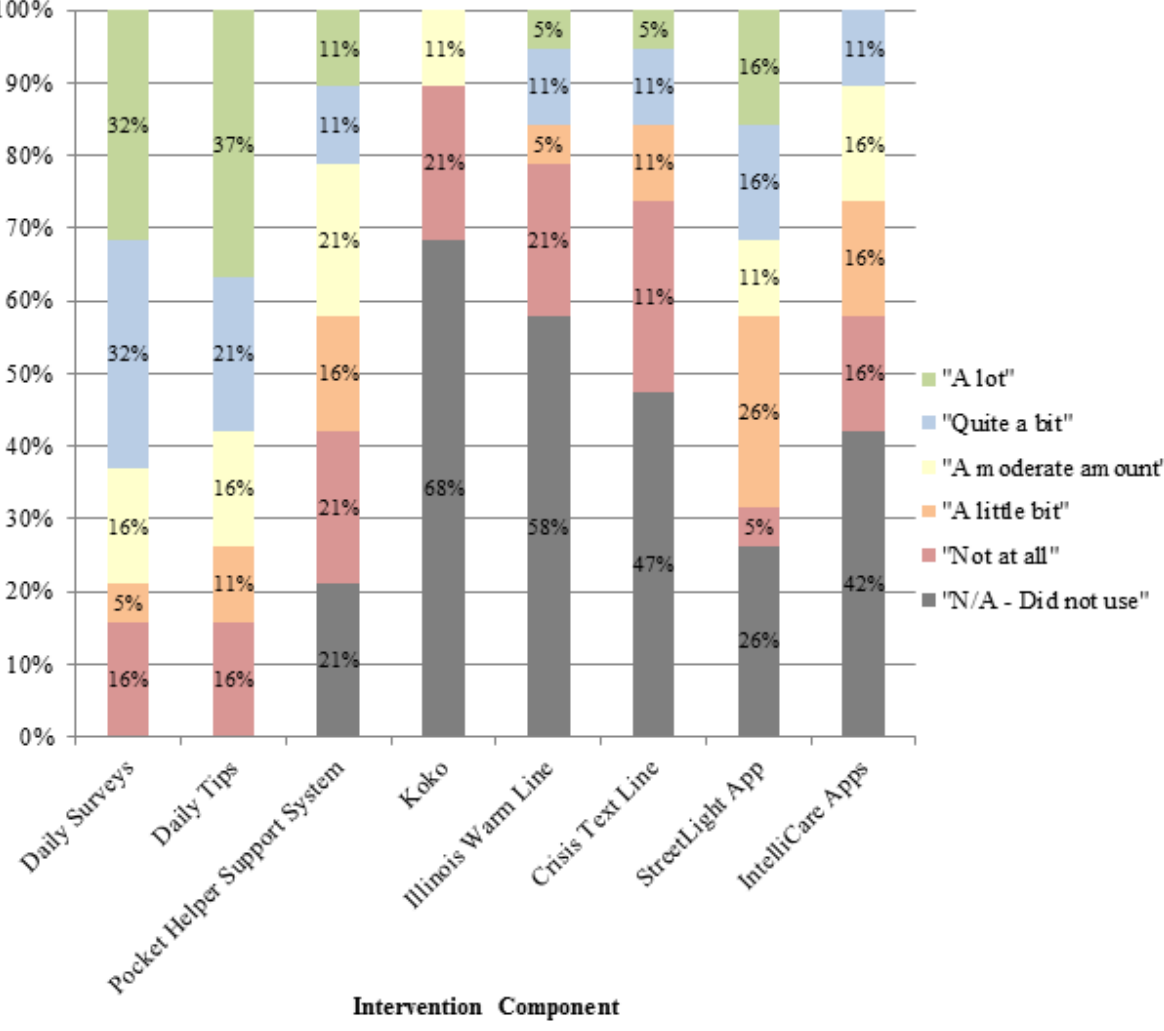
Figure 4. Self-reported benefit of intervention features at the 6-month end point. N/A: not